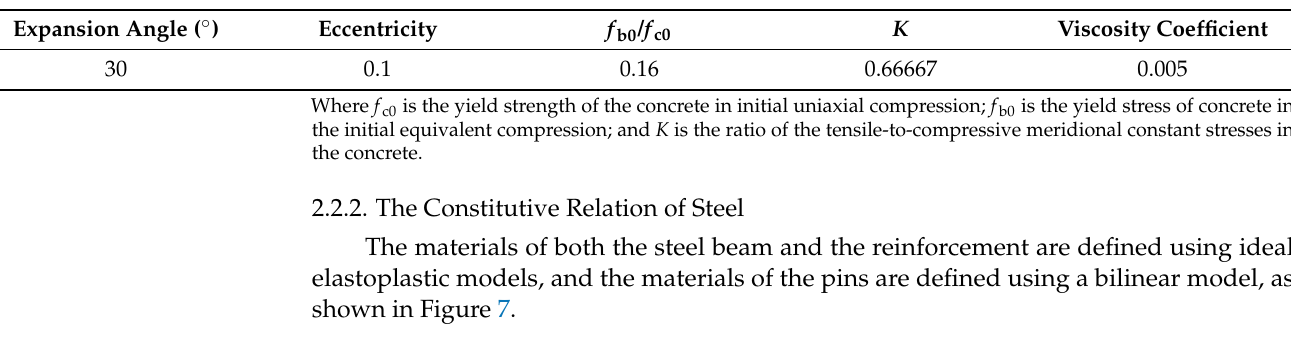
Table 1. Parameters of the plastic damage constitutive model of concrete.